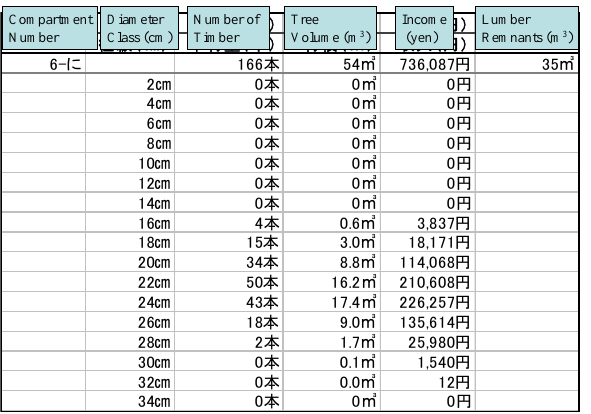
Figure 9. Result of Forest Resource Estimation